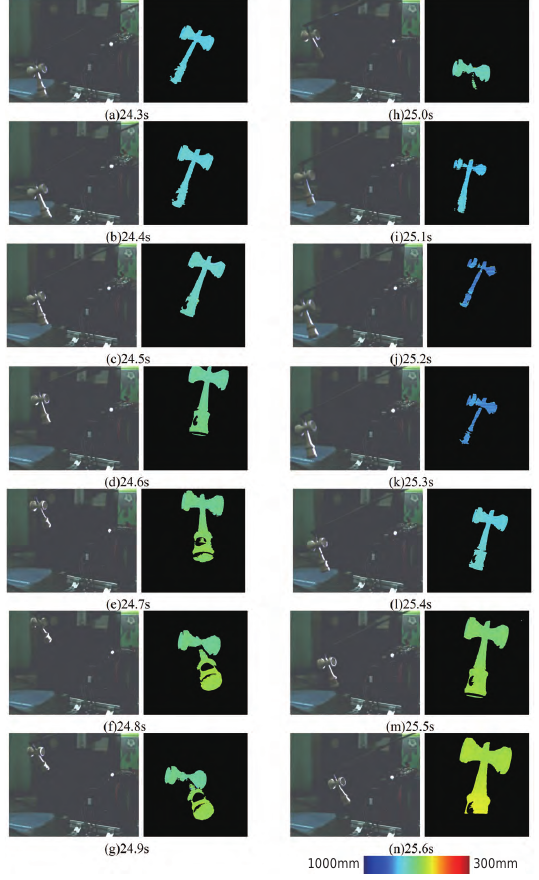
Figure 9. 3-D measurement with target tracking